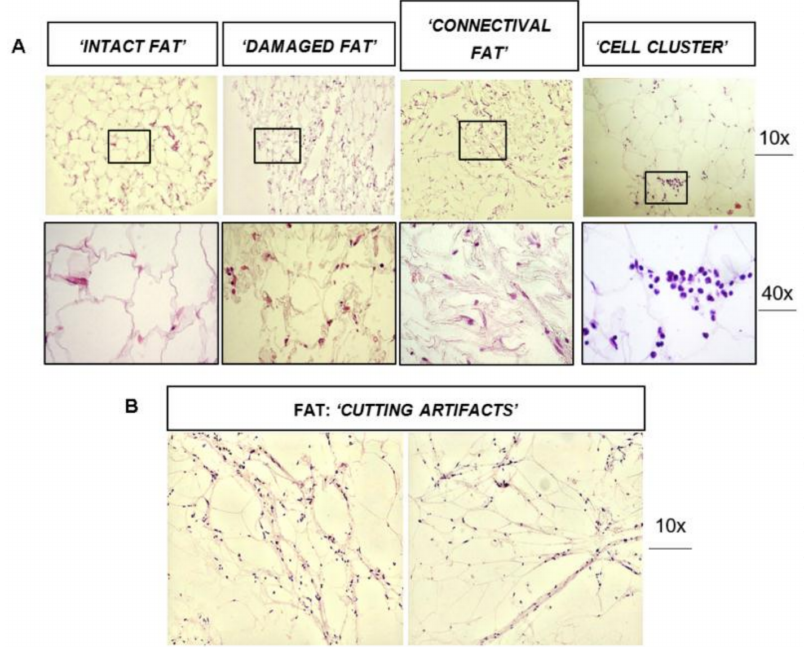
Figure 1. Histological analysis of fat graft ( ± SVF) before transplantation performed by H&E staining. ( A ) The ‘intact fat’ (normal-shaped adipocytes), the ‘damaged fat’ (irregular-shape adipocytes, with irregular cytoplasmic rims), the ‘connectival fat’ (stromal scaffolding of adipose tissue), ‘cell clusters’ (small group >15 cells of round shaped cells within the fat context) in comparison. ( B ) Fat with relevant damaged and then